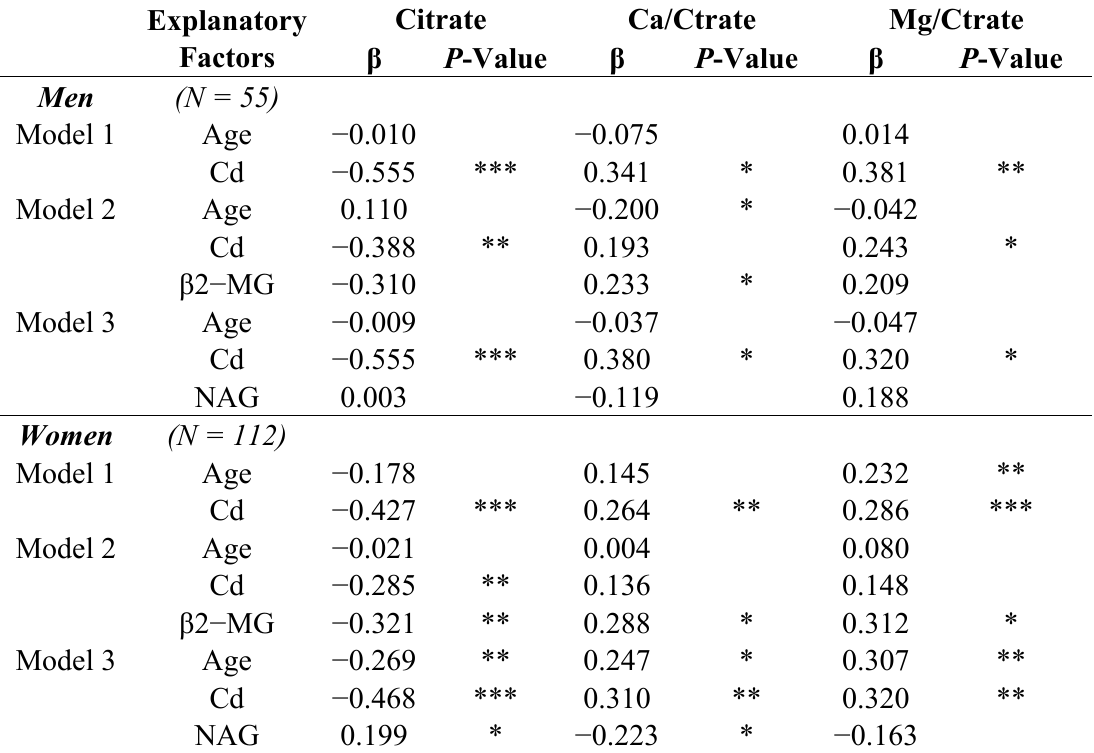
Table A1. Standardized regression coefficients ( β ) for urinary cadmium and renal markers in linear regression model for urinary citrate, calcium/citrate and magnesium/citrate in